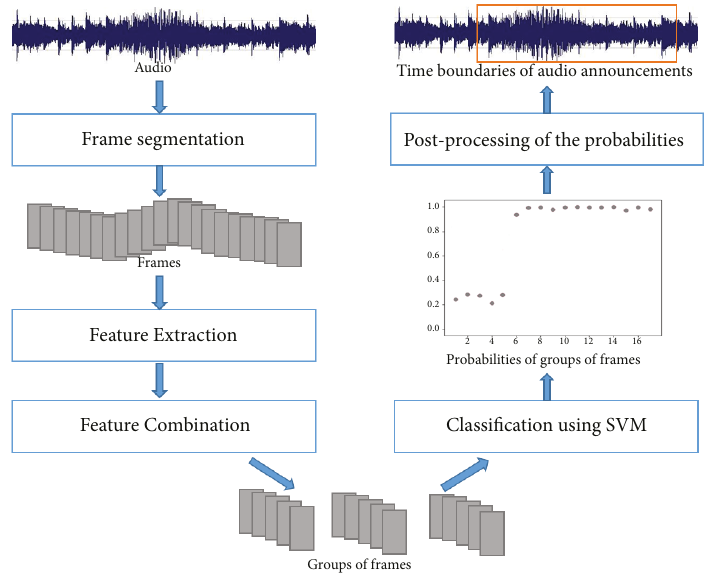
Figure 4: The procedure of audio announcement